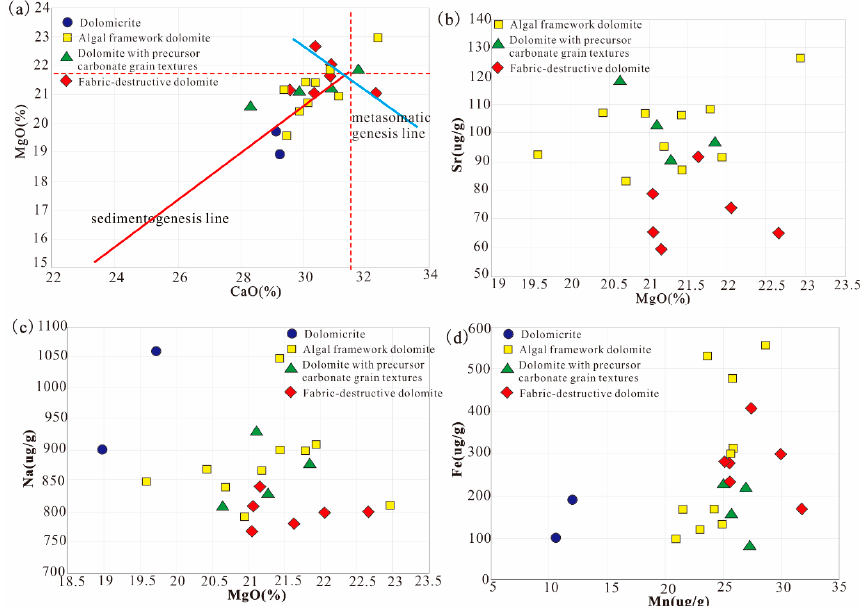
Figure 6. Cross plot of MgO/CaO ( a ), Sr/MgO ( b ), Na/MgO ( c ), and Fe/Me ( d ) for Leikoupo Formation dolomite, Western Sichuan Basin. Formation dolomite, Western Sichuan